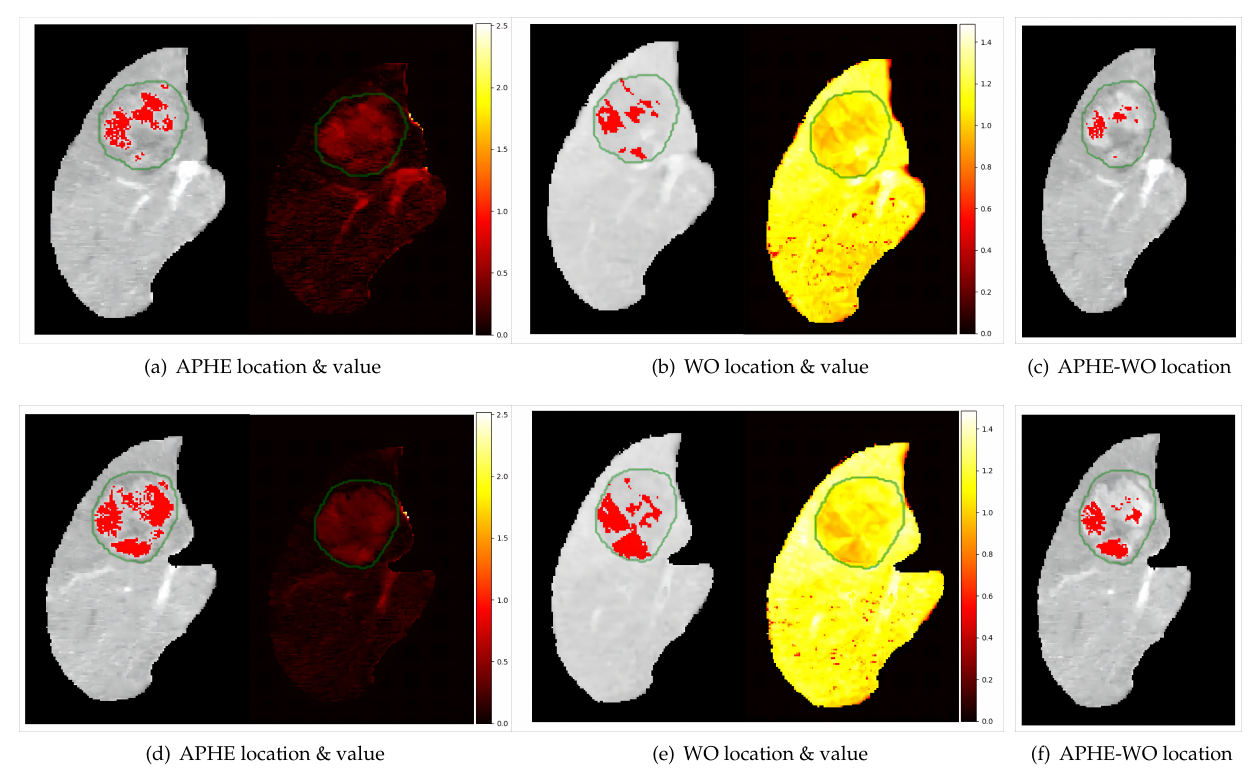
Figure 8. Images ( a – c ) are the same slice and ( d – f ) are the other same slice. The locations are shown on the AP liver image, and the heat map displays the corresponding quantitative estimation results, where the green contour is the lesion